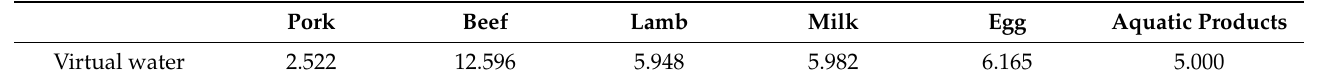
Table 3. Animal product quality virtual water content (unit: m 3 /